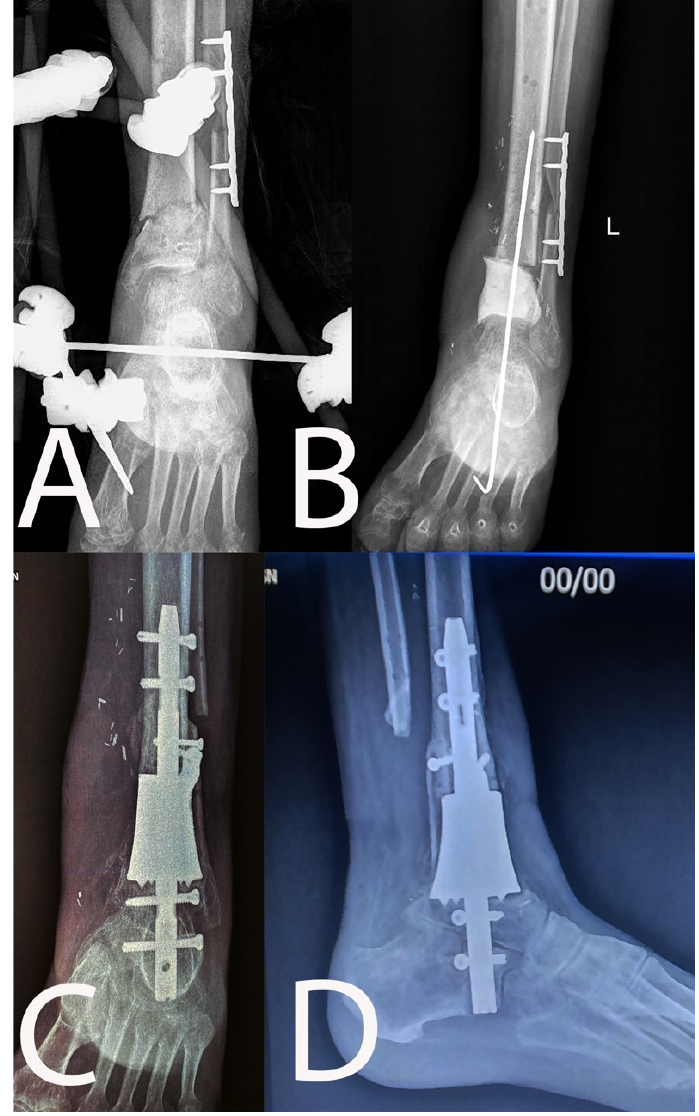
Figure 3. Chronic osteomyelitis of the distal tibia with non-healed pseudoarthrosis (( A ): pre-operative anteroposterior X-rays) treated with resection and antibiotic-loaded spacer (( B ): anteroposterior X-rays). Reconstruction was performed in ankle arthrodesis using a silver-coated custom-made prosthesis (7 months follow-up X-rays, ( C ): anteroposterior view, ( D ): lateral view). Patients were evaluated with DT X-rays and blood CRP monthly during the first 6 months and every 3 months up to the 2nd year after